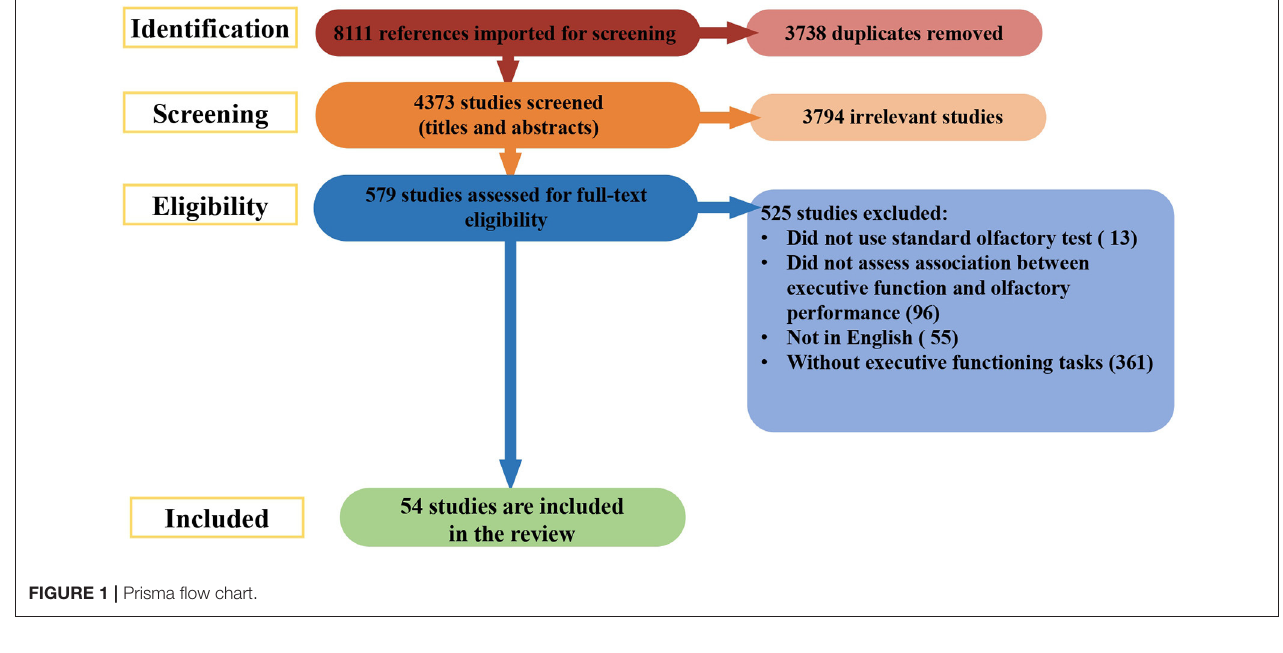
FIGURE 1 | Prisma flow chart.